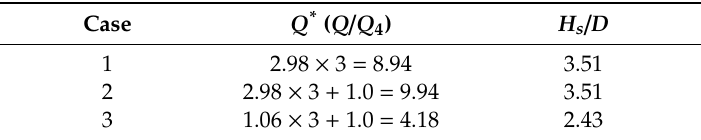
Table 3. Operating